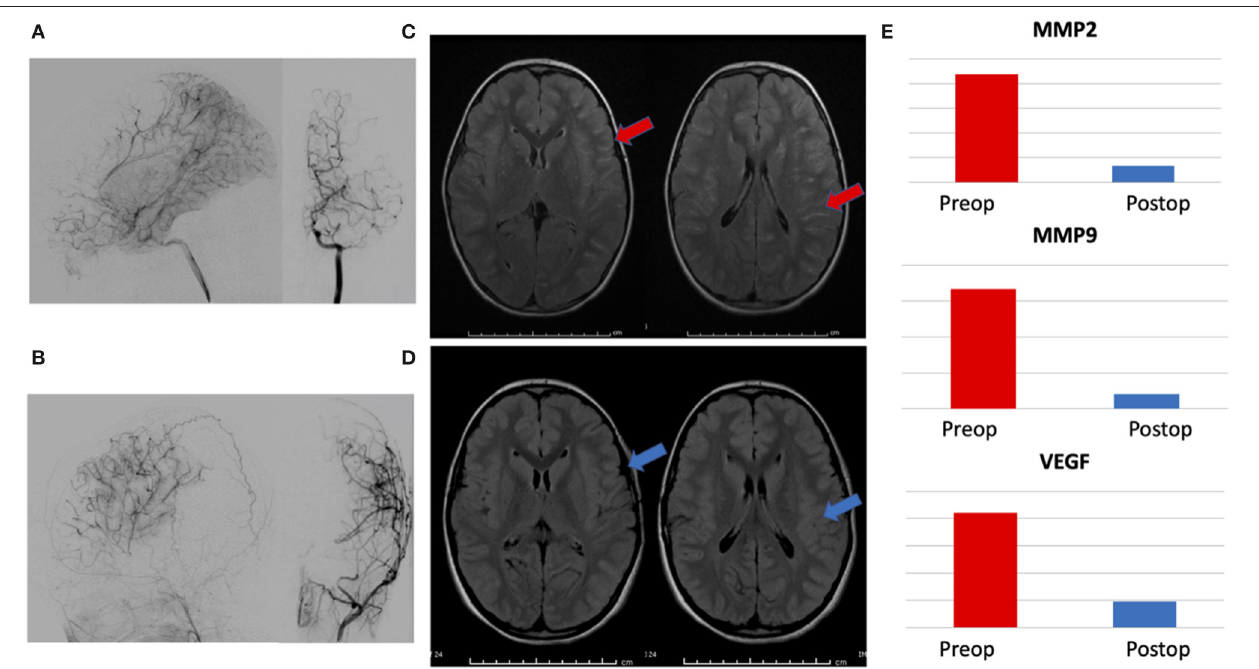
FIGURE 3 | Representative patient demonstrating correlation between radiographic changes and biomarker levels. (A) Preoperative angiogram with lateral and AP views of internal carotid artery injection showing Suzuki II-III moyamoya, (B) 1 year postoperative angiogram with lateral and AP views of external carotid injection showing Matsushima A surgical collaterals, (C) preoperative axial FLAIR MRI images demonstrating hyperintense sulcal signal—ivy sign, (red arrows) and (D) postoperative images showing marked resolution of ivy sign (blue arrows). (E) Reduction in postoperative levels of urinary biomarkers MMP-2, MMP-9, and VEGF, correlating with radiographic evidence of successful